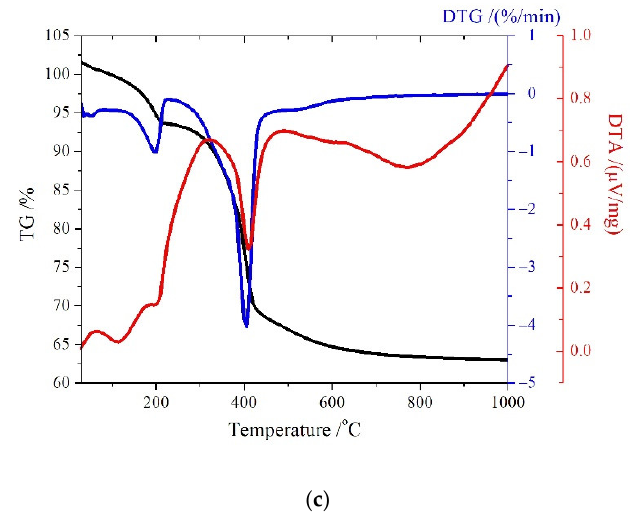
Figure 2. TG/DTG/DTA analysis of MgGa-CO 3 LDHs (Mg 2+ = 0.67 ( a ); 0.75 ( b ); 0.80 ( c )).